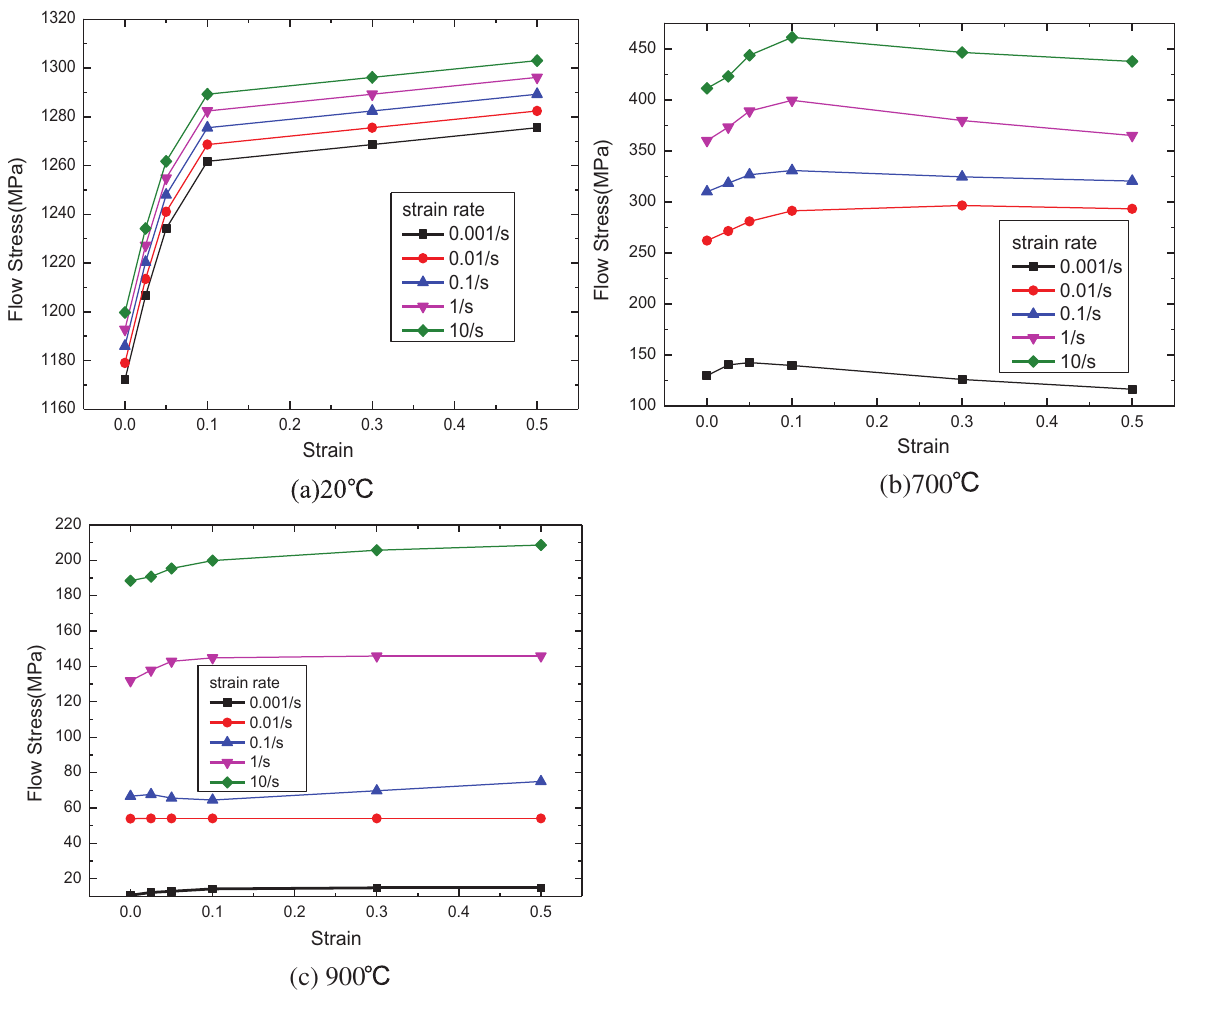
Figure 2: Flow stress curves at different strain rates in different